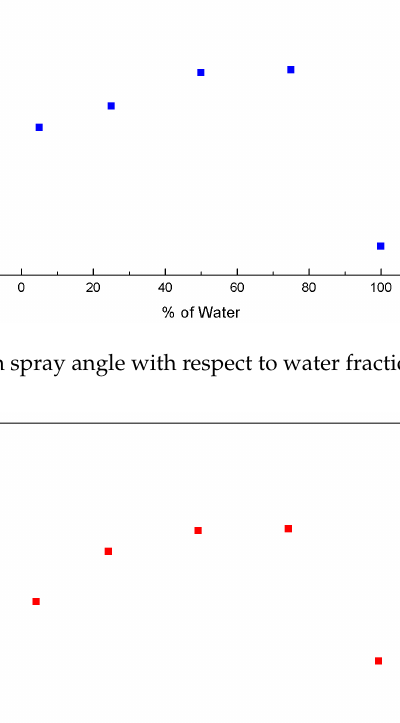
Figure 3. Effect of water fraction blended in water-LCO 2 mixture on spray pattern at 65/40 bar: ( a ) 0%;